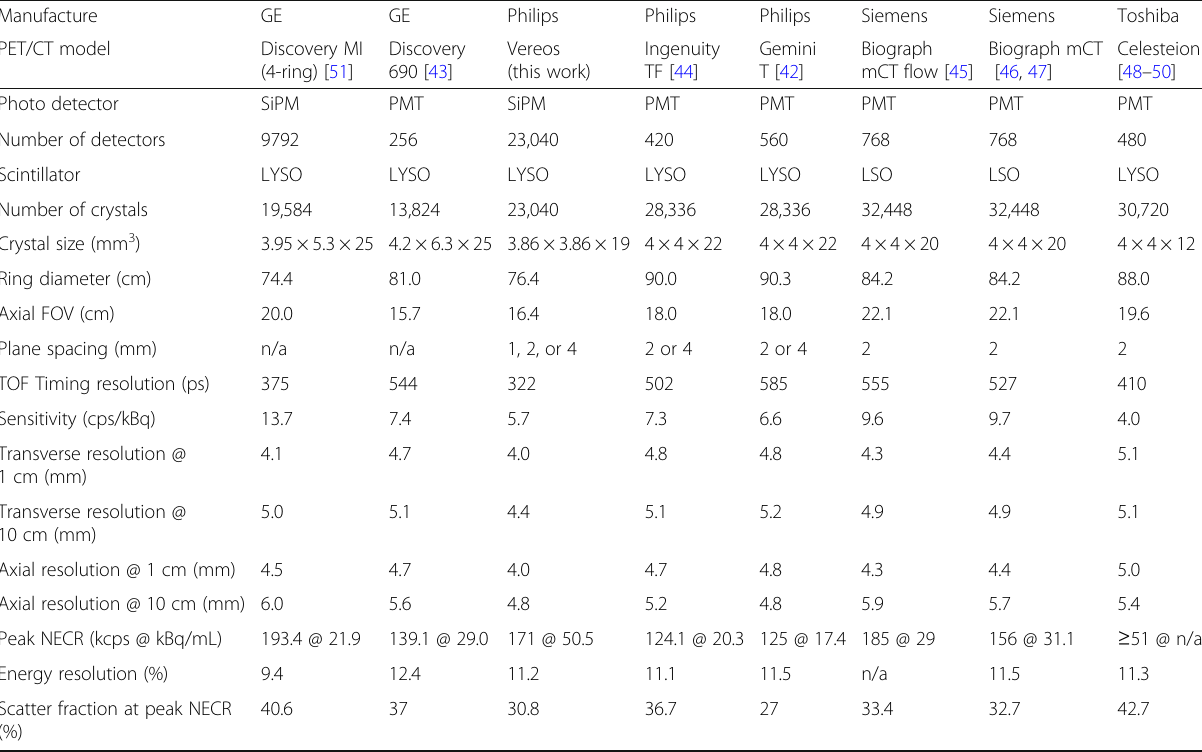
Table 2 Comparison of system characteristics across manufacturer PET/CT